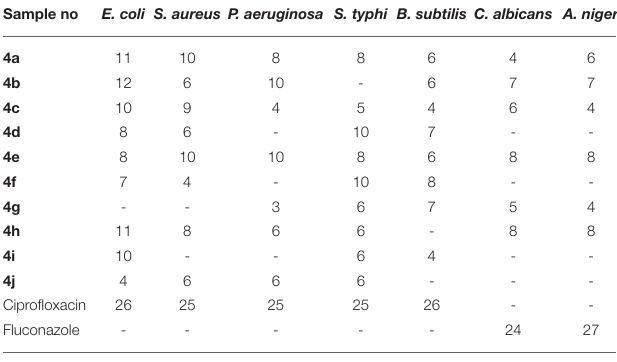
TABLE 6 | In vitro antioxidant activities (IC 50